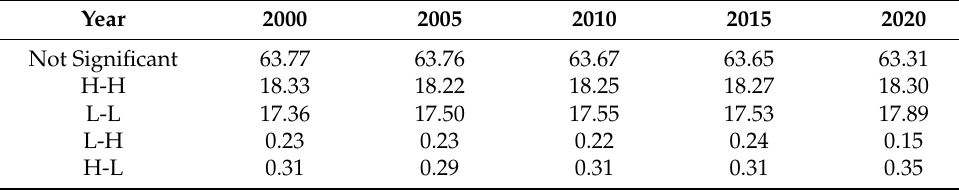
Figure 10. Local spatial autocorrelation clustering of habitat quality in the Yellow River Basin: ( a ) 2000 and ( b ) 2020. Table 13. Clustering statistic of the local Moran’s I i for habitat quality (%).